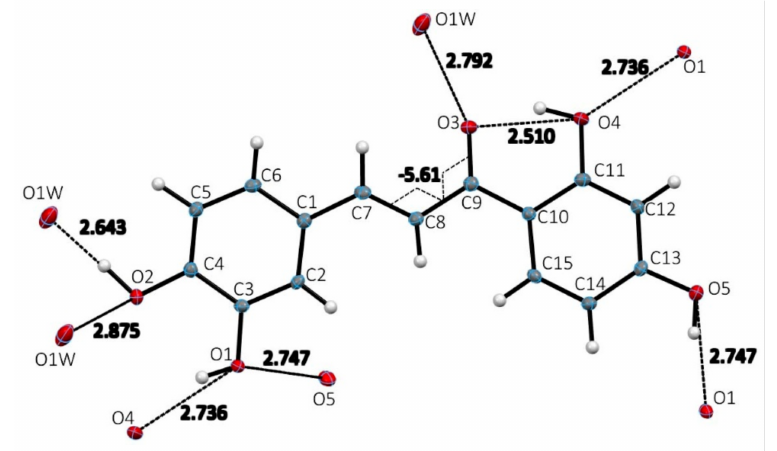
Figure 5. Atomic labeling, hydrogen bond distances surrounding single molecule and torsion angle in the molecular structure of Butein monohydrate. Three of four OH-groups, O2-H4, O1-H3, O4-H11 have two H-bonds. Hydroxyl O5-H13 has only one H-bond. Torsion angle C7-C8-C9-O3 is − 5.61 ◦ . Ellipsoids represent 50% anisotropic displacement parameters.